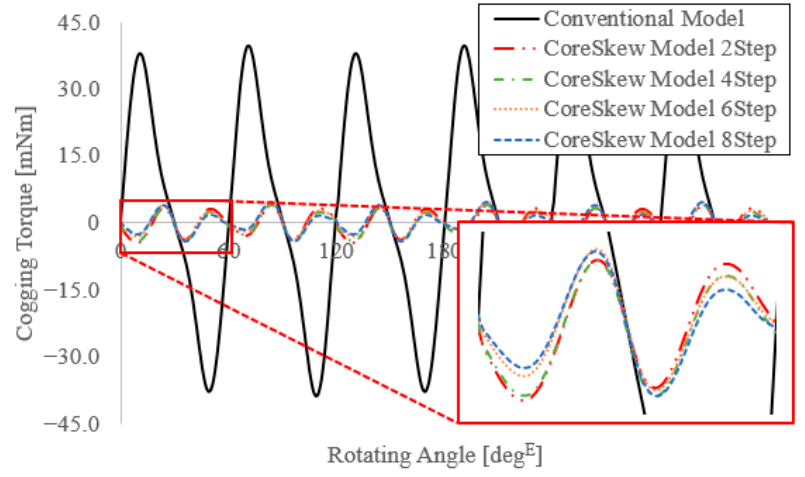
Figure 16. Cogging torque waveform comparison according to the number of steps.